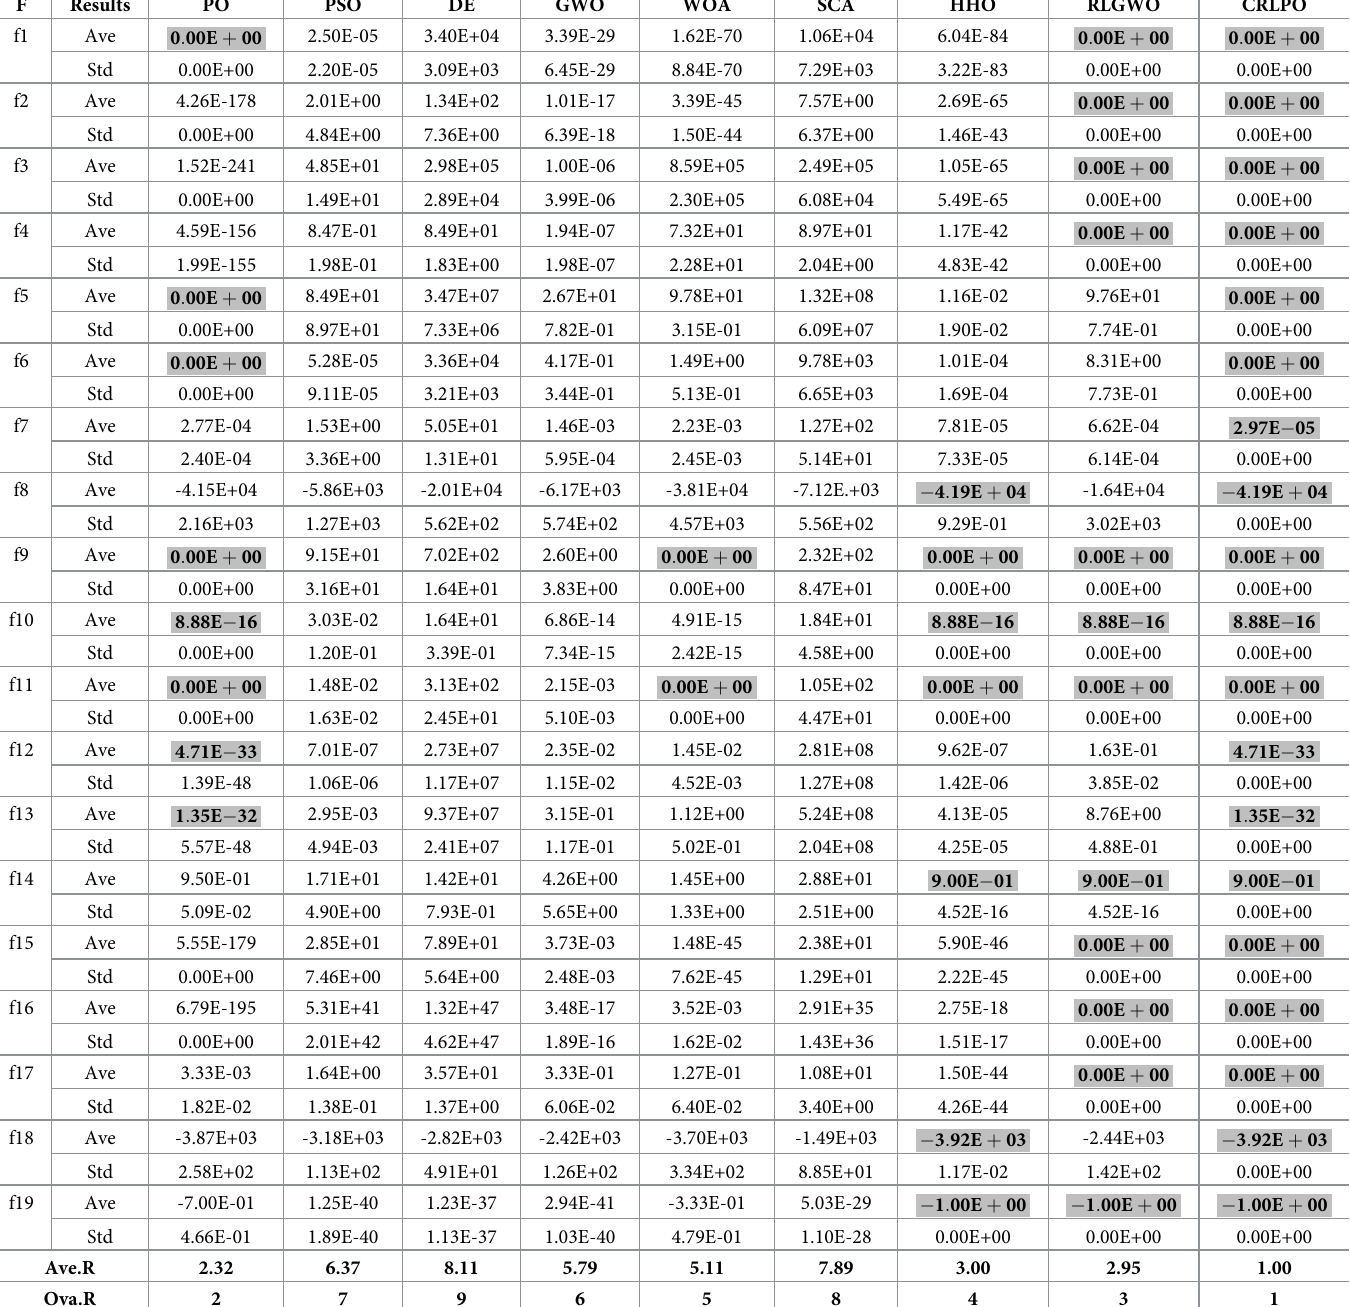
Table 4. Experimental results of 19 benchmark functions from Table 1 with 100